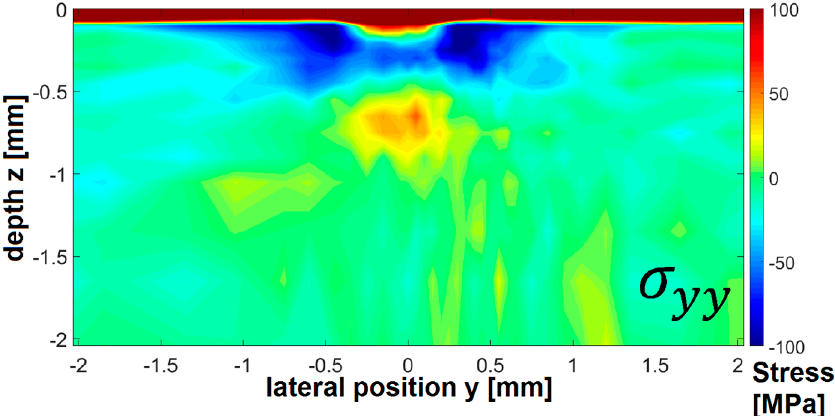
Figure 6. Internal full residual stress fields below the contact point after unloading of 3000 N external force in equivalent σ yy ( y , z ).